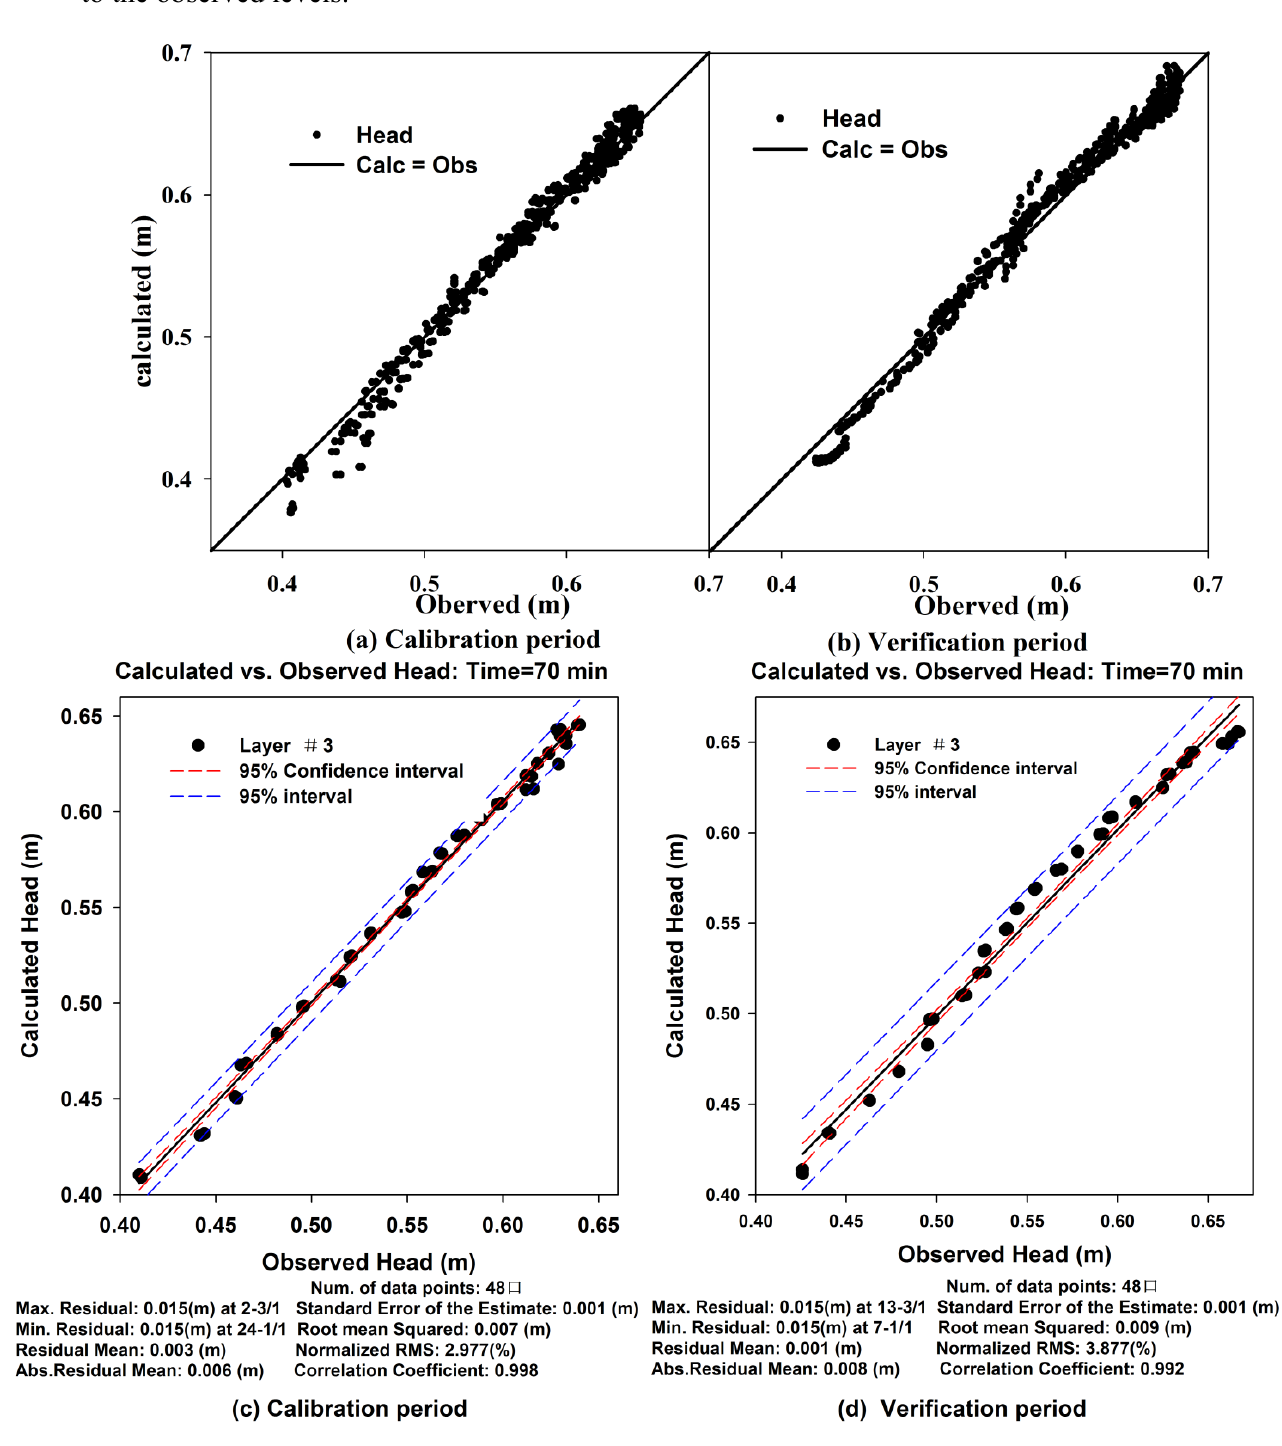
Figure 3. Scatter graphs of the calculated heads vs. observed values for the whole period and t = 70 min during the calibration period ( a , c ) and the verification period ( b , d ). The groundwater heads are shown as dots and the solid lines mean the calculation heads are equal to the observed